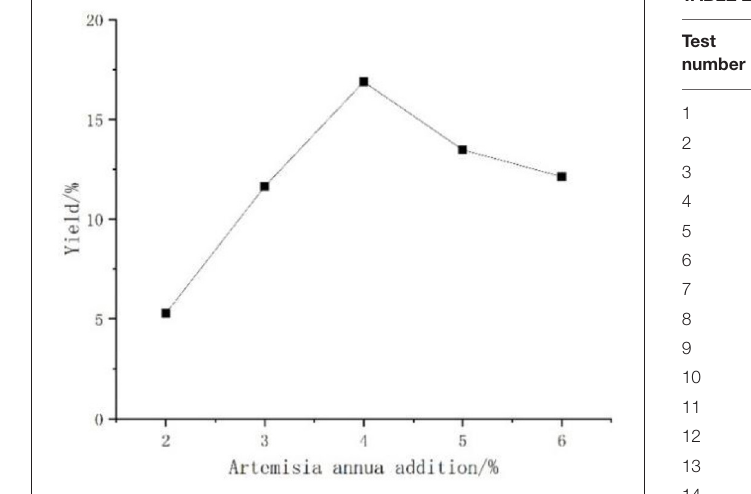
The regression model significance test and anova were performed